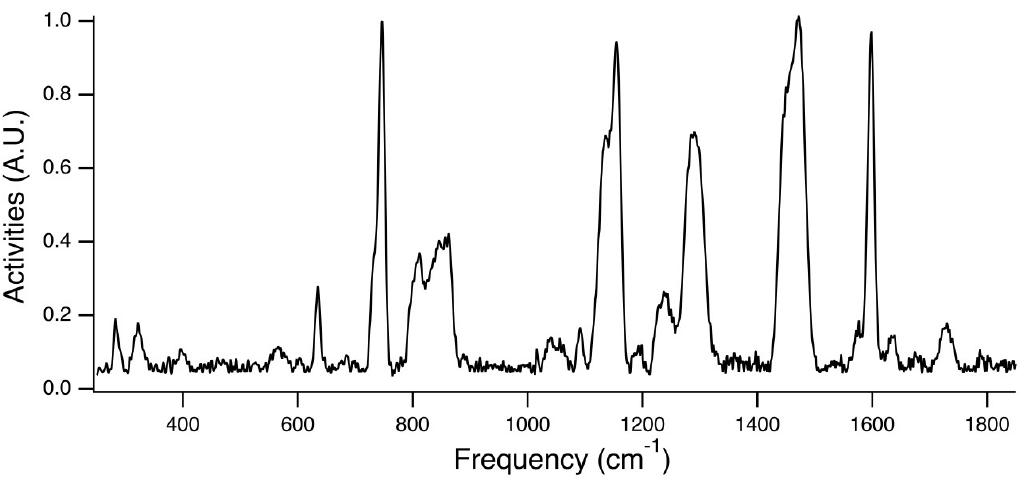
Figure 7. Experimental Raman spectrum of PEG 31 DA ‐ x ‐ STFSILi.